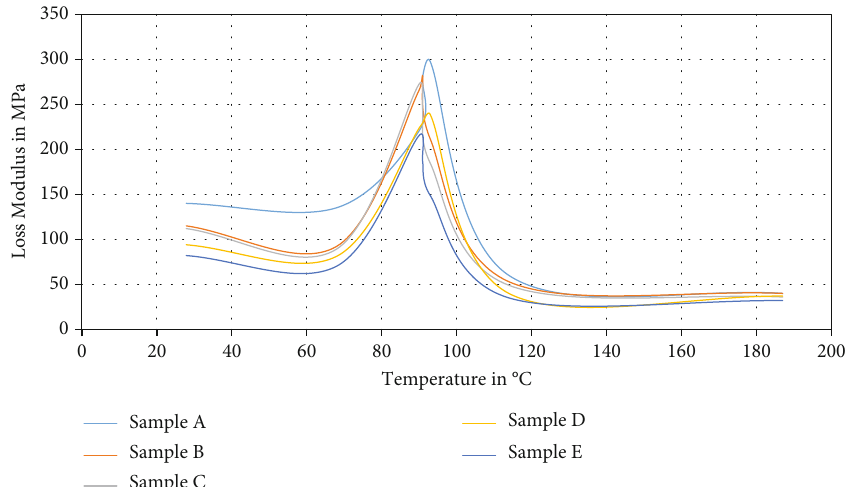
Figure 5: The loss modulus of an epoxy composite.